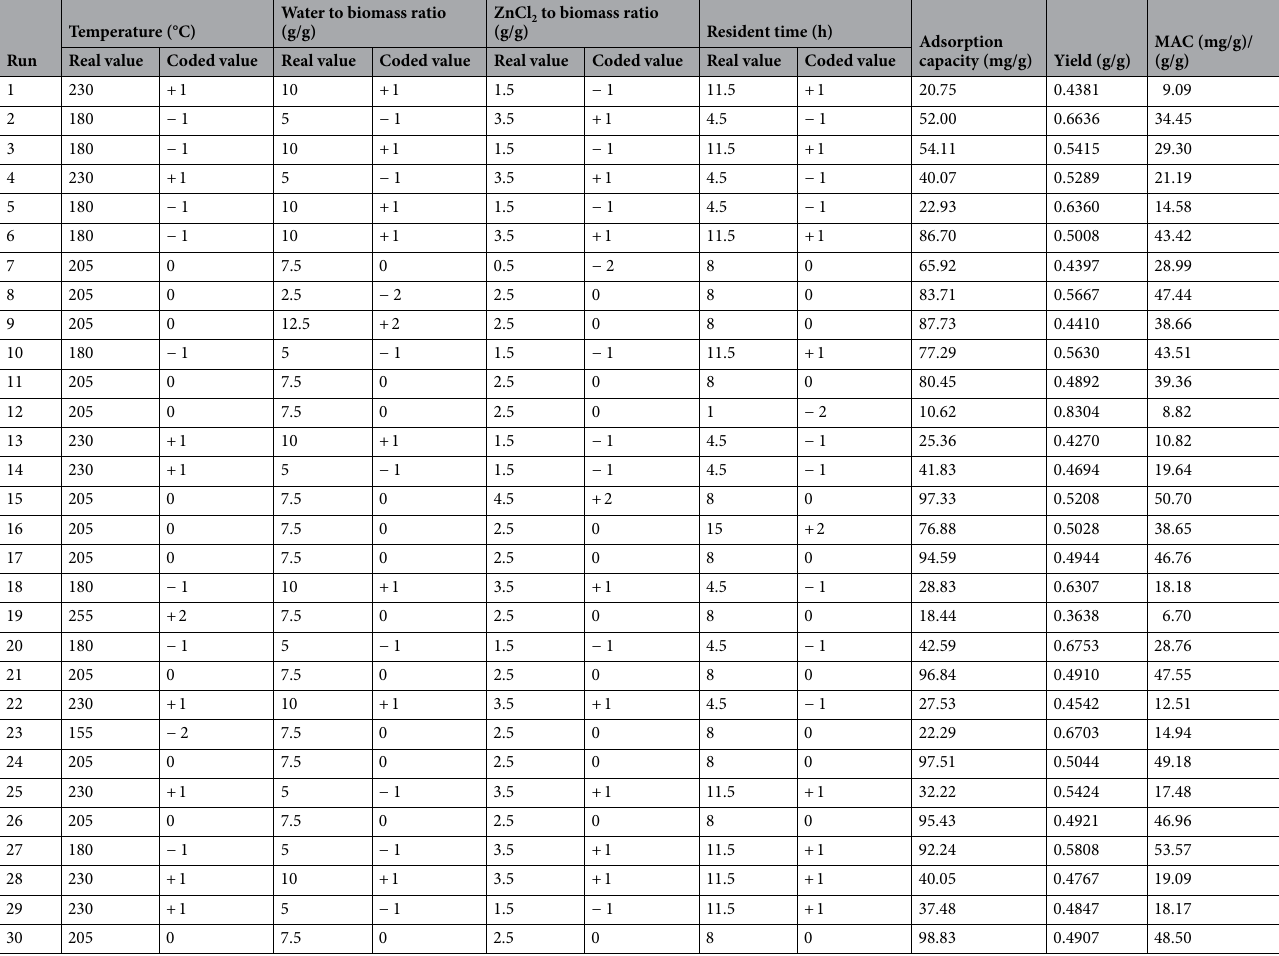
Table 1. Independent variables and corresponding response